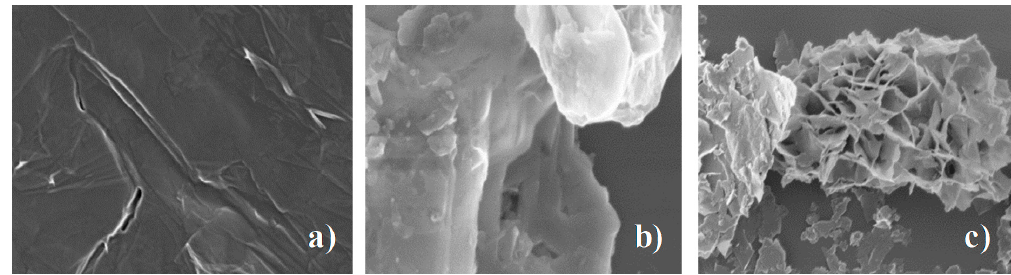
/ Bi composite ( b ) and ( c